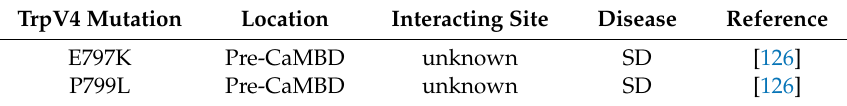
Table 5. Mutations in TrpV4 channels influencing CaM binding. SD: skeletal dysplasia. TrpV4 Mutation Location Interacting Site